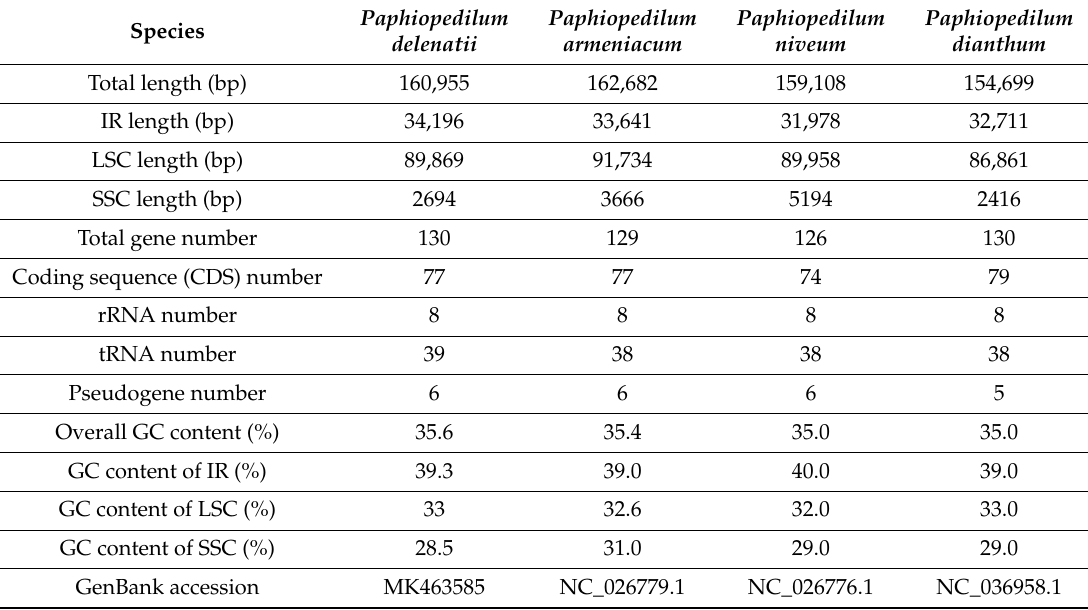
Table 2. Basic features of four Paphiopedilum chloroplast